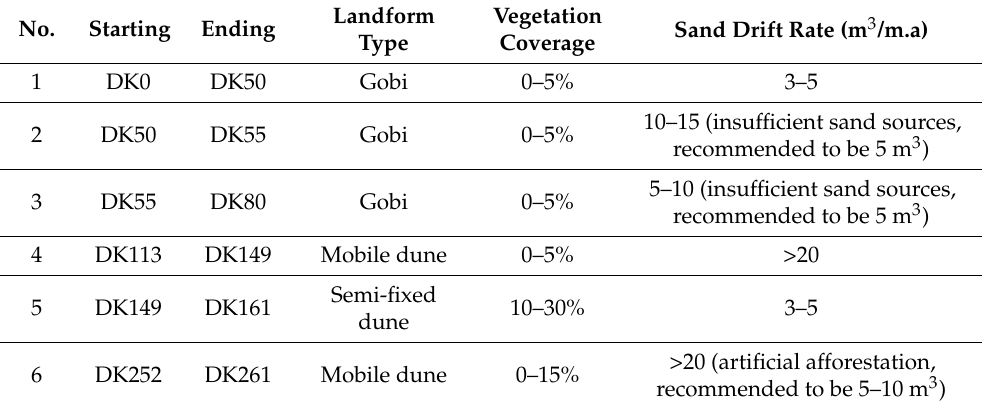
Table 1. Landform types and sand drift rates along the